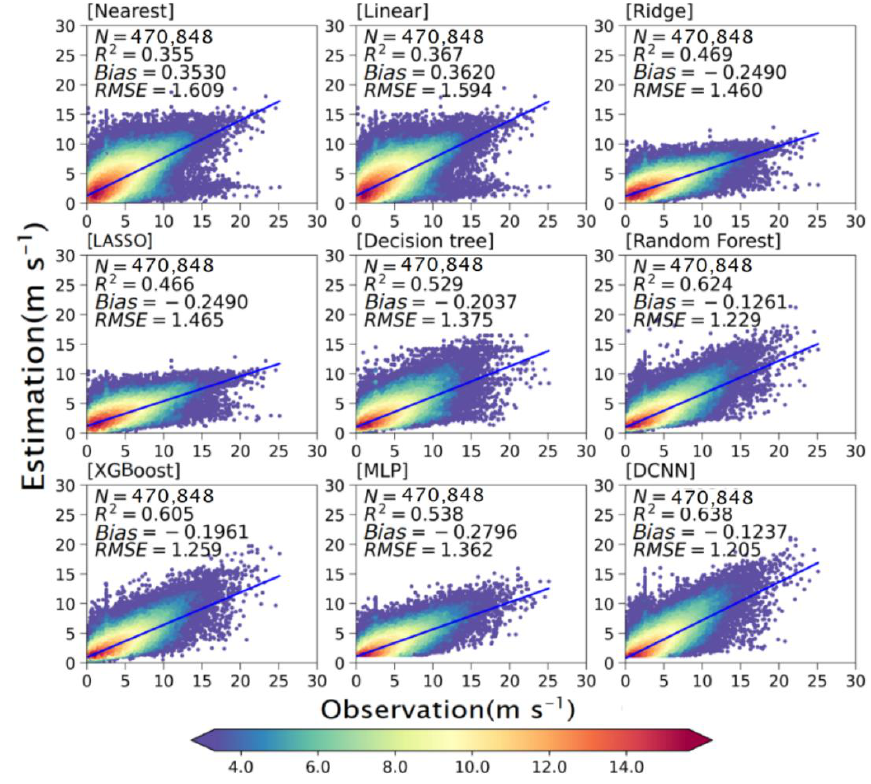
kernel density × 100,000. 2